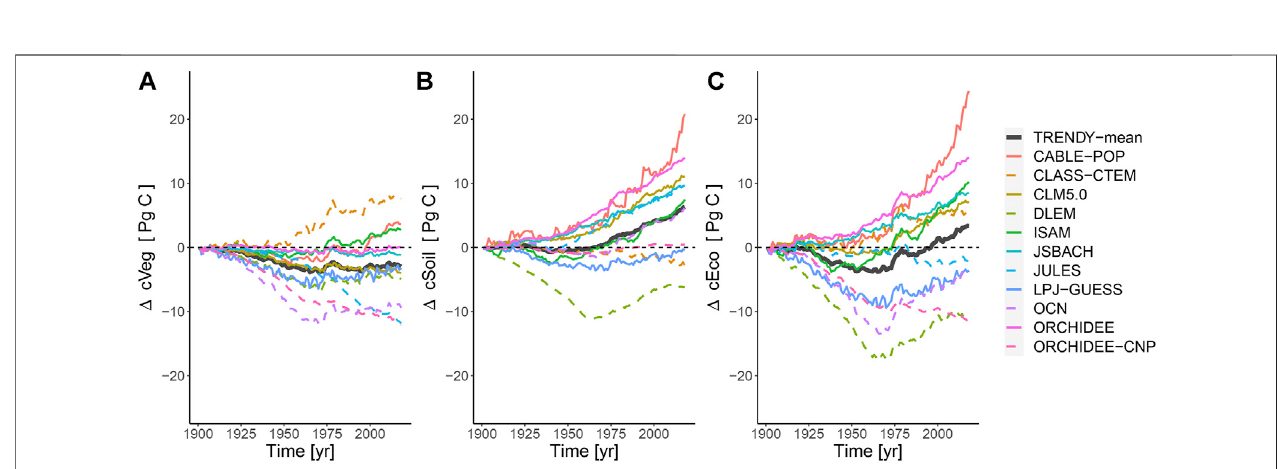
FIGURE 6 | Time-series of changes in (A) vegetation carbon, (B) soil carbon and (C) ecosystem carbon storage (soil plus vegetation) in global drylands between 1901 and 2018 as simulated by the models of the TRENDY ensemble. The divergence is shown relative to 1901. On average the models simulate an overall increase in ecosystem carbon over the century, particularly in the latter 70